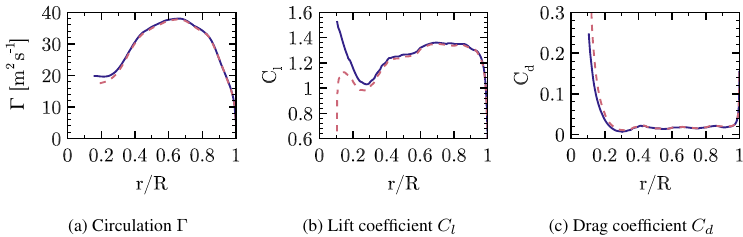
Figure 15. Distribution of aerodynamic coefficients along the blade radius for CaseIsoRotor (dashed) and CaseT1.0 (solid).